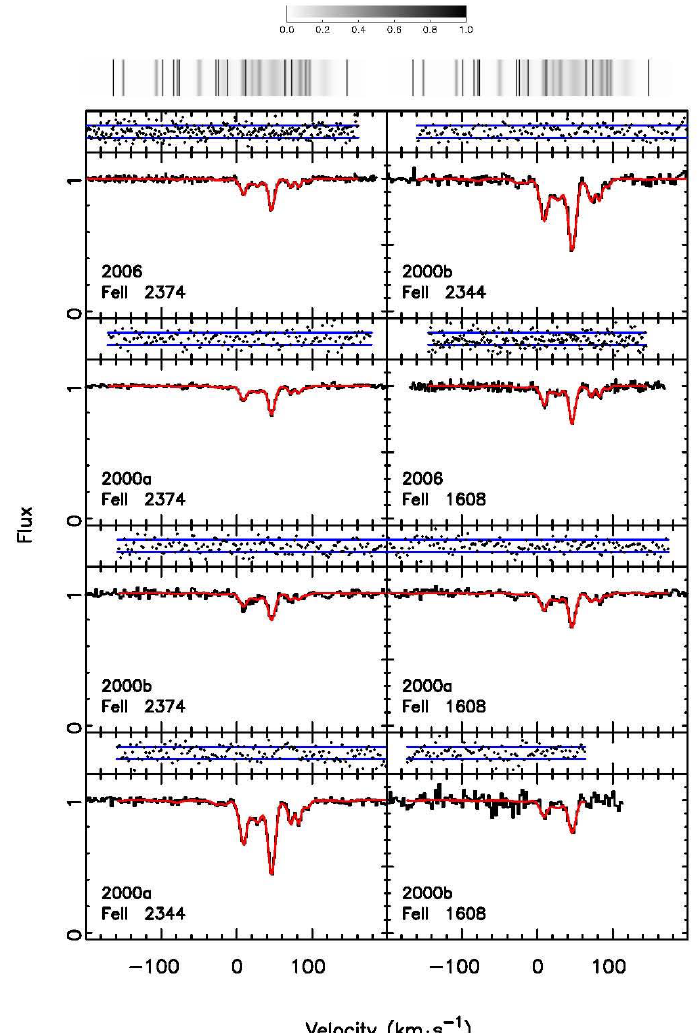
Figure 2. Comparison of the BMA model and the data for the most complex synthetic spectrum (37 velocity components) in our sample. Above the figure is a grayscale plot showing the relative likelihood of velocity components at each pixel (the scale is shown at the top). Each row in the figure shows two panels: the top panel compares the residuals (black points) to the 1 σ expected fluctuations (horizontal blue lines). The bottom panel compares the BMA model (smooth red line) to the data (black). The BMA model is determined by summing over all models weighing by the relative likelihood of each model. Figure 1 shows the first 10 data regions contributing to the ∆ α / α analysis. Here we show the remaining 8 data